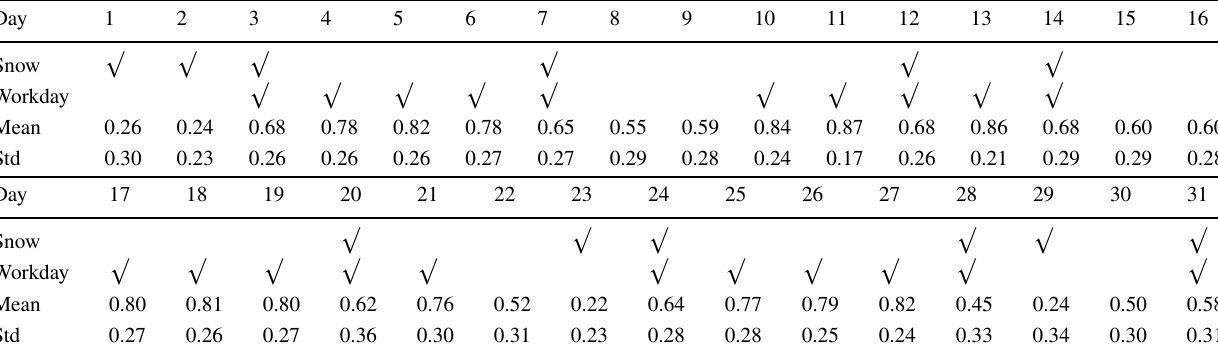
Table 2 Factors in December 2012